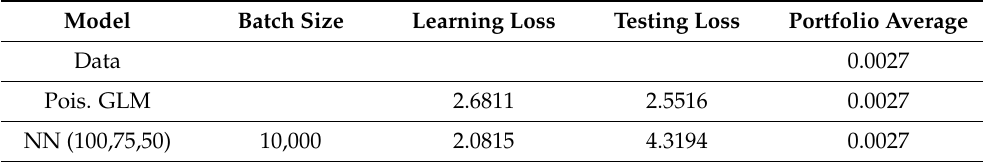
Table A4. The testing loss, learning loss, and portfolio average of Poisson regression model and